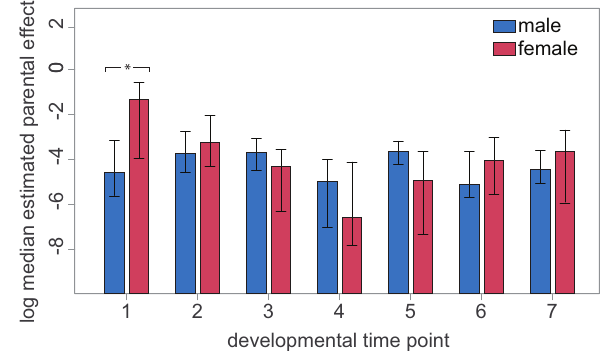
Figure 3. Parental components to gene expression variation. Median female and male parental contributions to scaled expression variation (variance/mean 2 ; see Methods) are plotted for each time point on a log scale to facilitate visualization (analyses were carried out on untransformed values using non-parametric tests); whiskers on each bar indicate quartiles. Maternal effects significantly exceed paternal effects only at the first time point and paternal effects are relatively uniform across